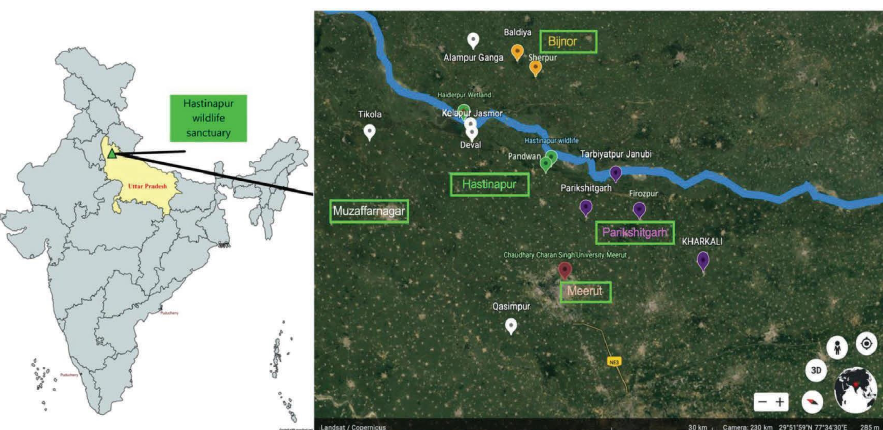
Figure 1: Map of India to show the location of Hastinapur wildlife sanctuary (left panel) and diferent quadrants (green boxes) and sites of study (right panel: yellow-Bijnor, green-Hastinapur, white-Muzafarnagar, and purple-Parikshitgarh).